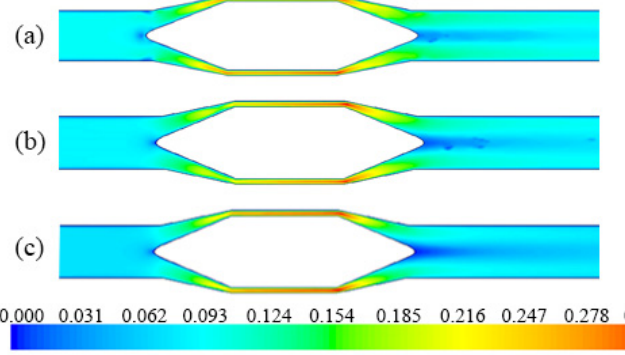
Figure 11. Solids velocity profile (m / s): ( a ) case #1.4, d = 1.34 mm; ( b ) case #3.4, d = 0.91 mm; ( c ) case #5.5, d = 0.54 mm.